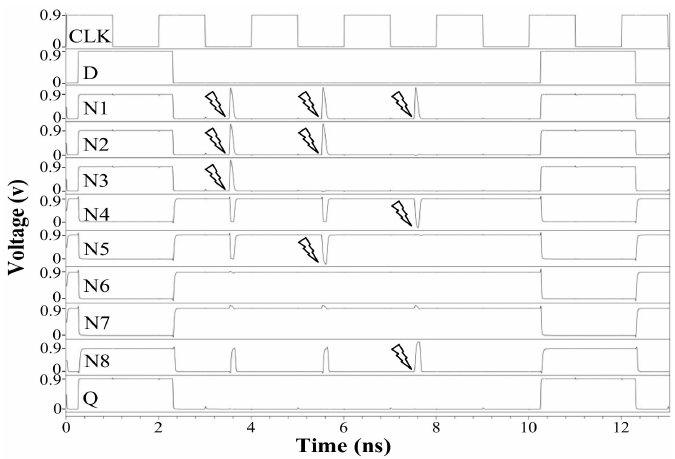
Figure 13. Simulation for TNU injections of HTNURL latch.